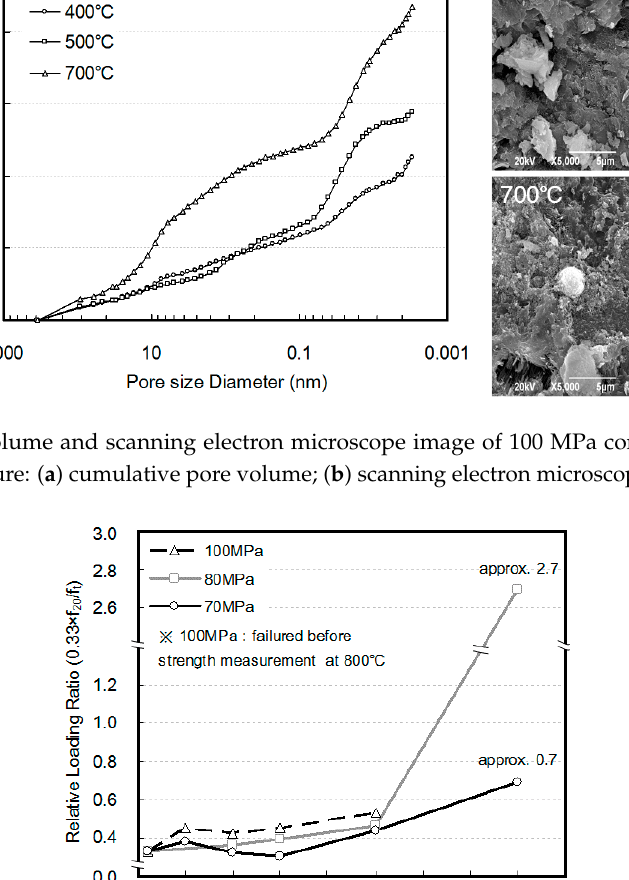
Materials 2017 , 10 , 781 9 of 14